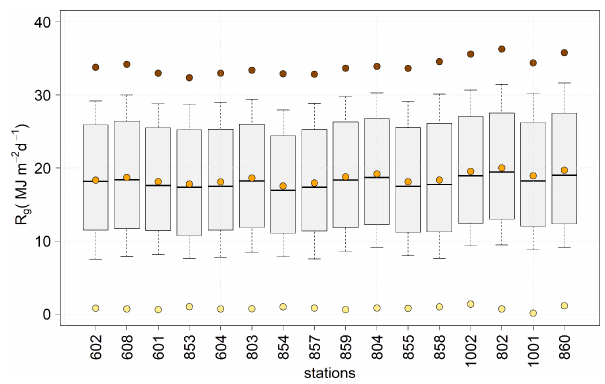
Figure 5. Statistical distribution of daily R g (MJm − 2 d − 1 ) time series at each of the selected stations over the study area. The box shows 50% of the data, delimited by Q1 (lower) and Q3 (upper), the solid line represents the median, and whiskers show 10th and 90th percentiles. Brown, orange, and yellow dots represent daily maxi- mum, mean, and minimum time series values. Stations are sorted by increasing altitude from left to right.